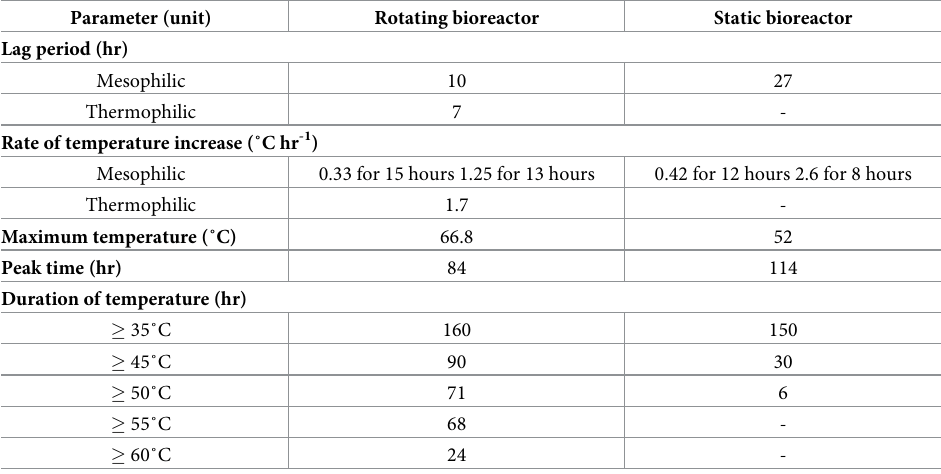
Table 1. Thermal kinetic parameters estimated for the rotating and static